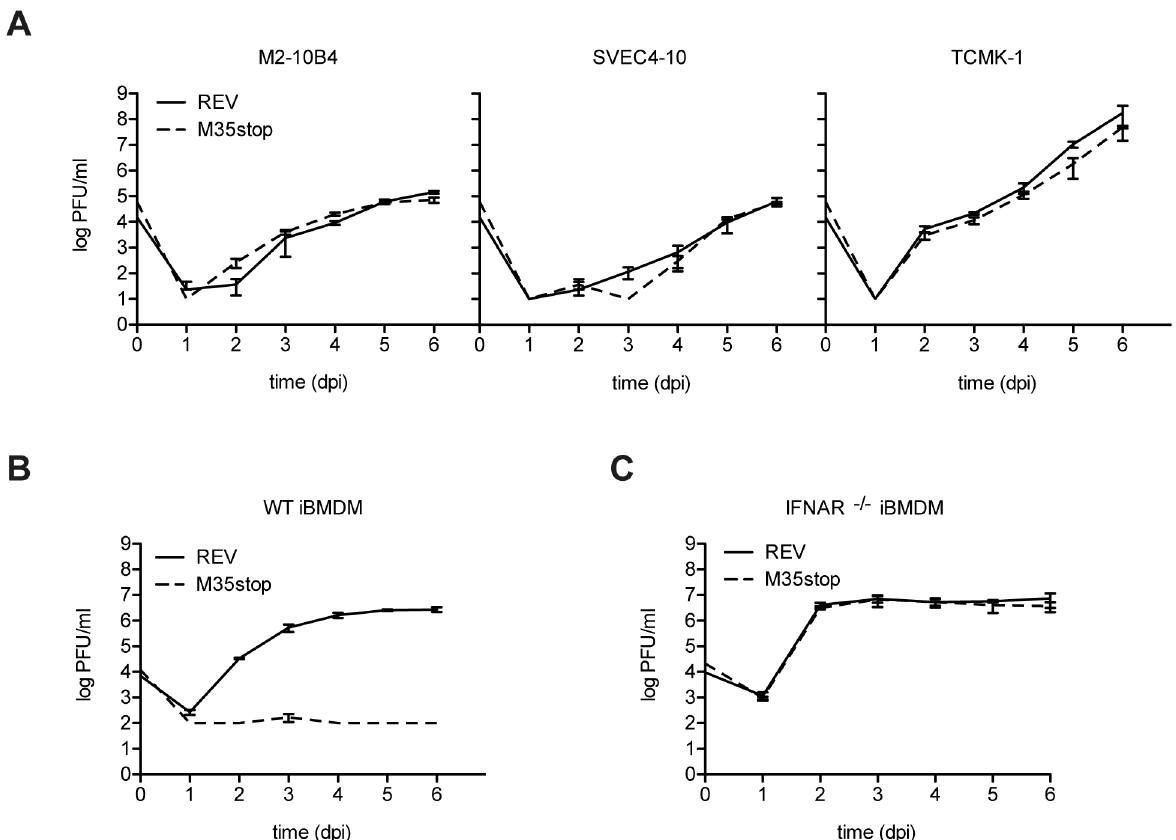
Fig 8. M35 is a determinant for MCMV replication in macrophages. (A) Multistep growth analysisof MCMV-M35stop-REV (REV) or MCMV-M35stop (M35stop) infection(MOI 0.05) in M2-10B4 stromal cells (left panel), SVEC-10 endothelialcells (central panel)or TCMK-1 epithelialcells (right panel). Supernatant was harvested at indicateddays post infection (dpi) and viral titers were determinedby standard plaqueassay. The limit of detectionis 10 PFU/ml. One representative of two independentexperiments performed in triplicates is shown. Data is shown as mean ± SD. (B) Multistep growth analysisof MCMV-M35stop-REV (REV) or MCMV-M35stop (M35stop) infection (MOI 0.05) in immortalized WT BMDM as in (A). The limit of detection is 100 PFU/ml. One representative of two independent experiments performed in triplicates is shown. Data is shown as mean ± SD. (C) Same as for (B) but with immortalized BMDM derived from IFNAR1 -/-